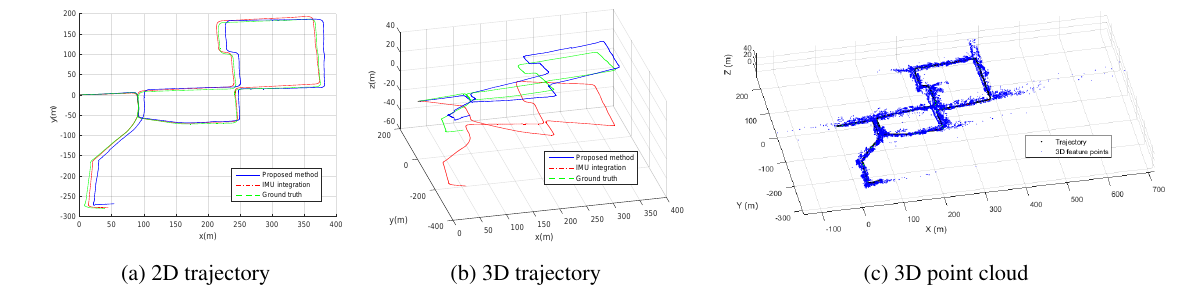
Figure 7: The trajectory estimated by our method from 3D point cloud